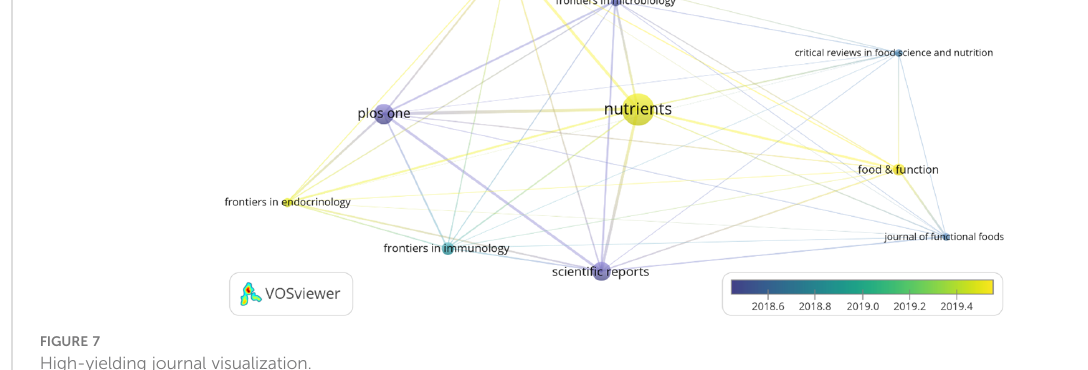
FIGURE 7 High-yielding journal visualization.